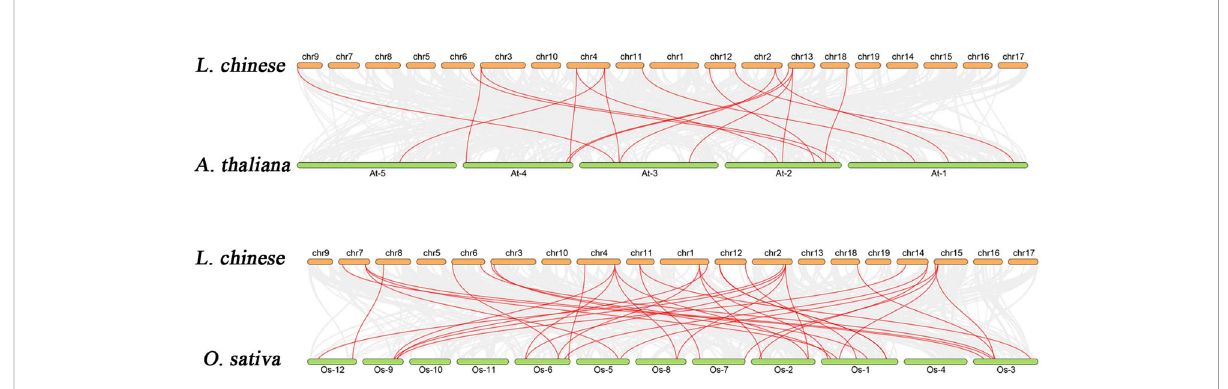
FIGURE 6 Analysis of the collinear relationship between the bzip gene of L. chinense and the bzip gene of Arabidopsis and Oryza